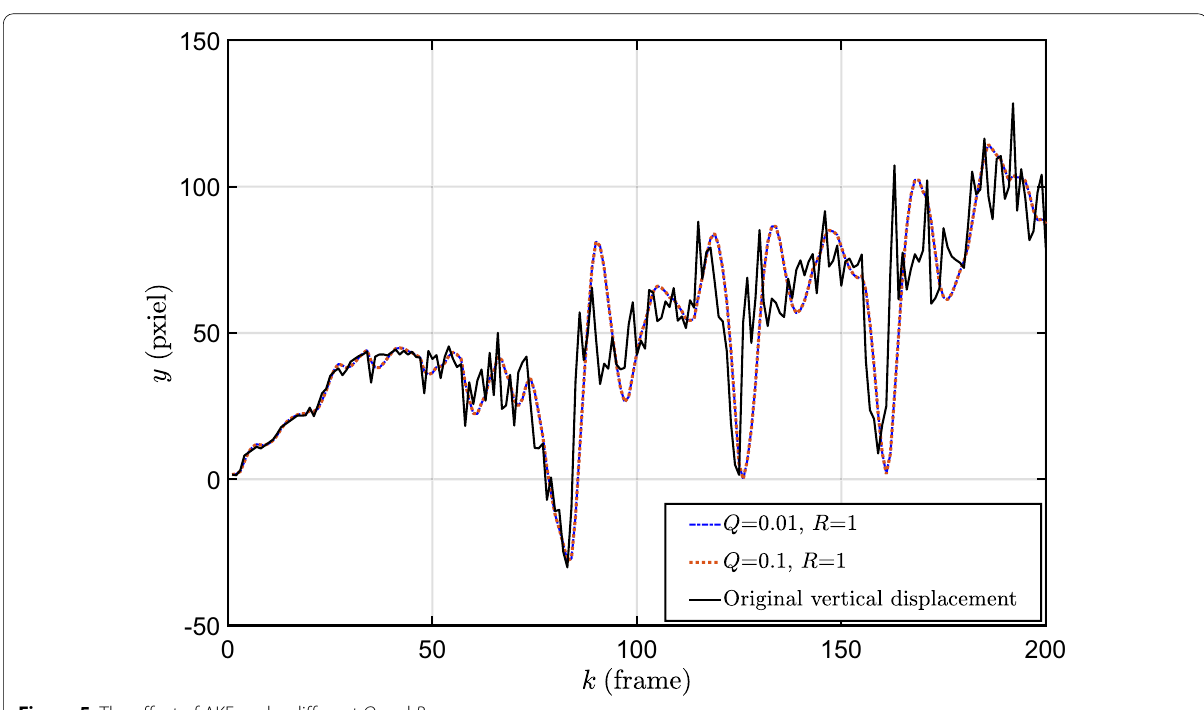
Figure 5 The effect of AKF under different Q and